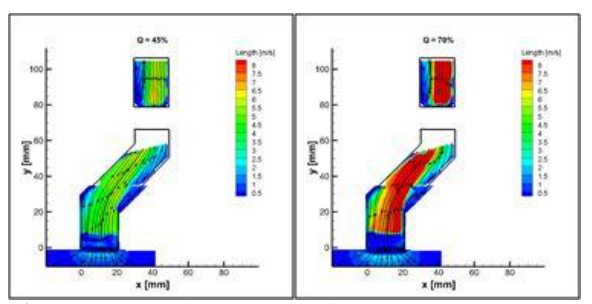
Fig. 15. Velocity field evaluated for channel No. 2 and two flow